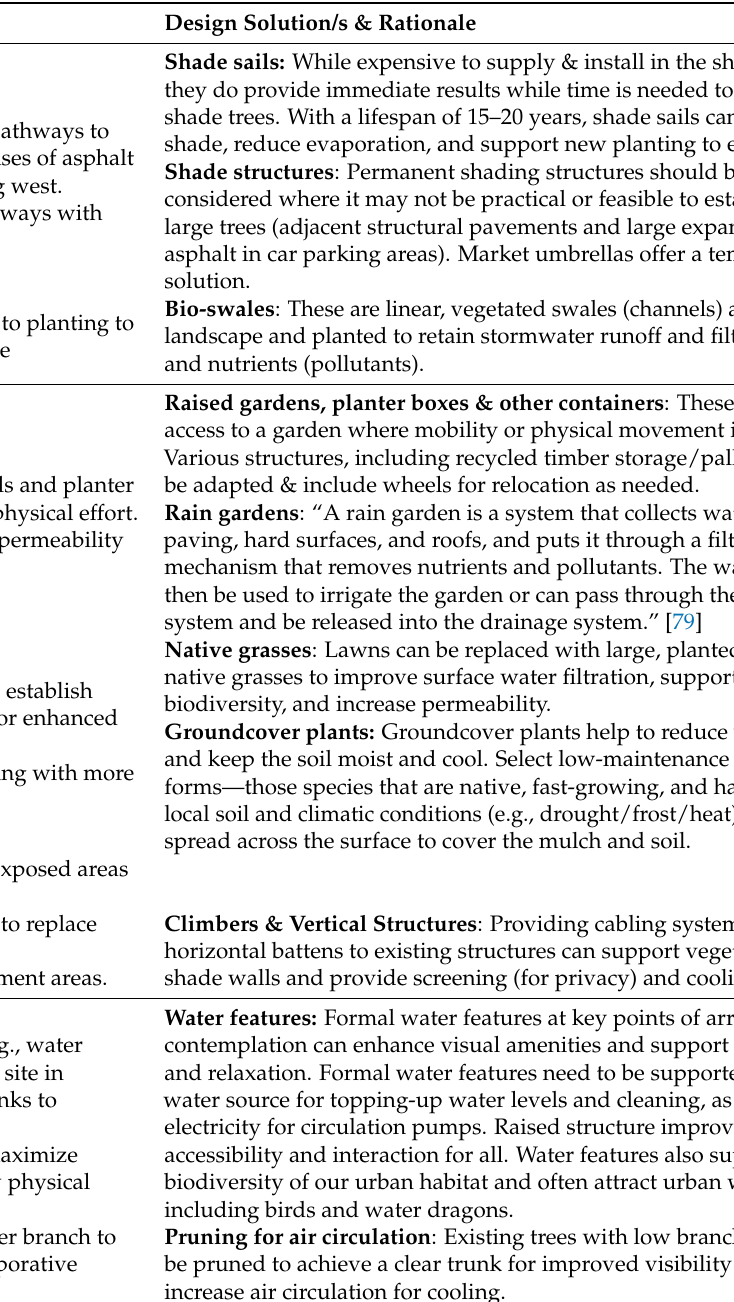
Table 4. Mitigation strategies for Bli Bli and Caloundra ACFs to reduce heat and thermal